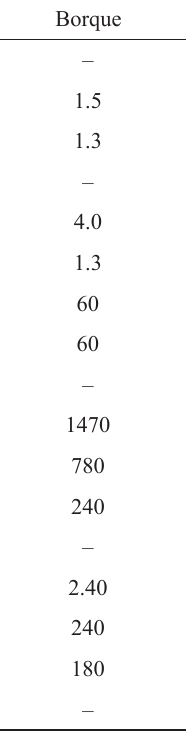
Table 1 – Compositions of the selected media for PHB production in bubble column bioreactor by the isolated methanotroph Mineral